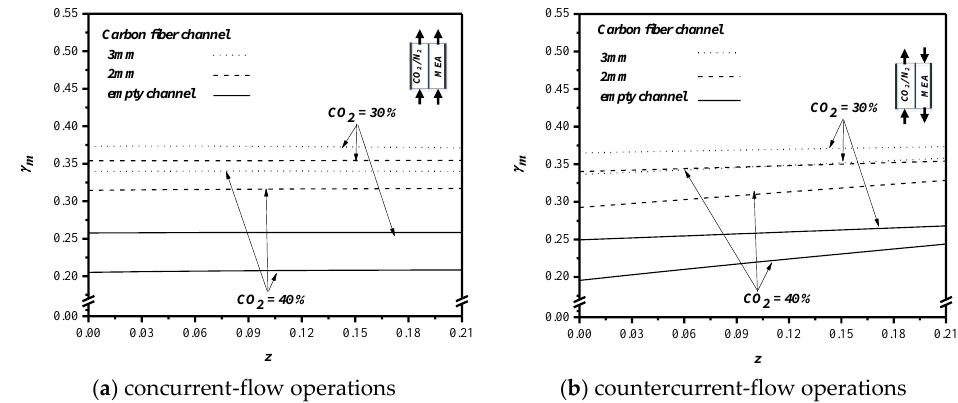
Figure 11. Effects of the width of carbon-fiber spacers and CO 2 concentration on m γ . ( a ) concurrent- flow operations; ( b ) countercurrent-flow operations. operations; ( b ) countercurrent-flow